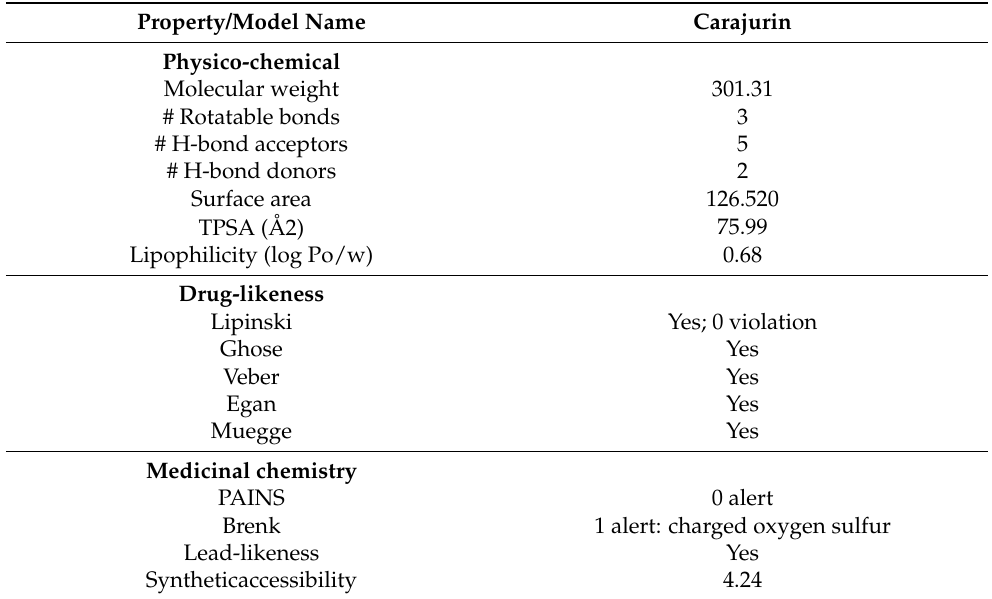
Table 3. Predicted physicochemical, drug-likeness, and medicinal chemistry properties for